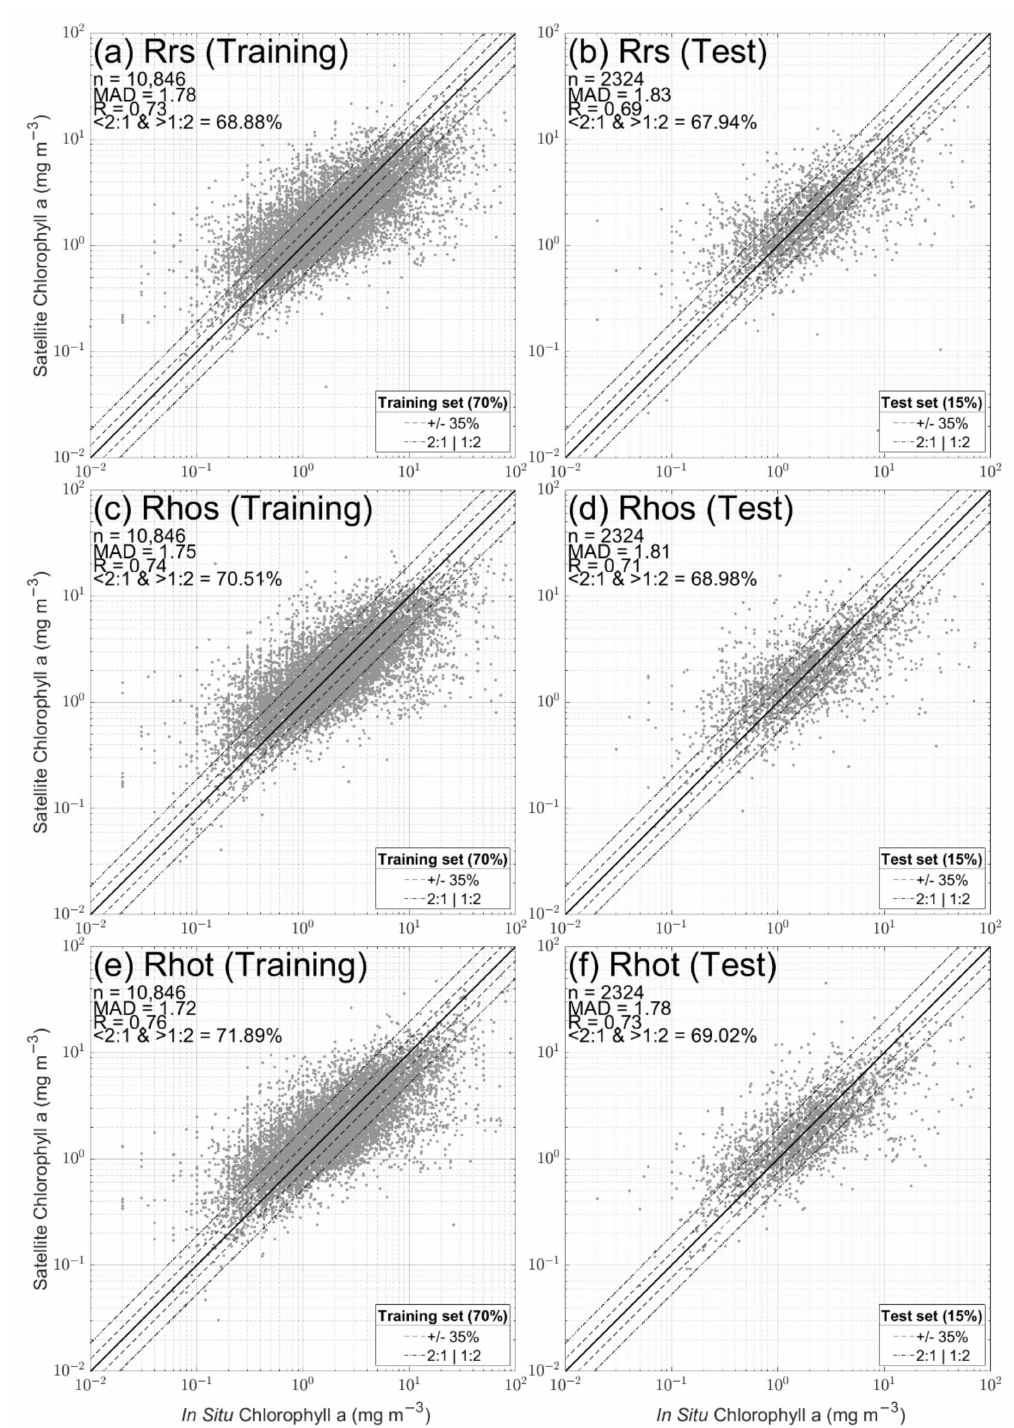
Figure 4. Neural network performances for an architecture based on 3 layers of 15 neurons each, using Rrs ( a , b ), Rhos ( c , d ), and Rhot ( e , f ) for the training set (70% of the total matchups) and the test set (15% of the total matchups),